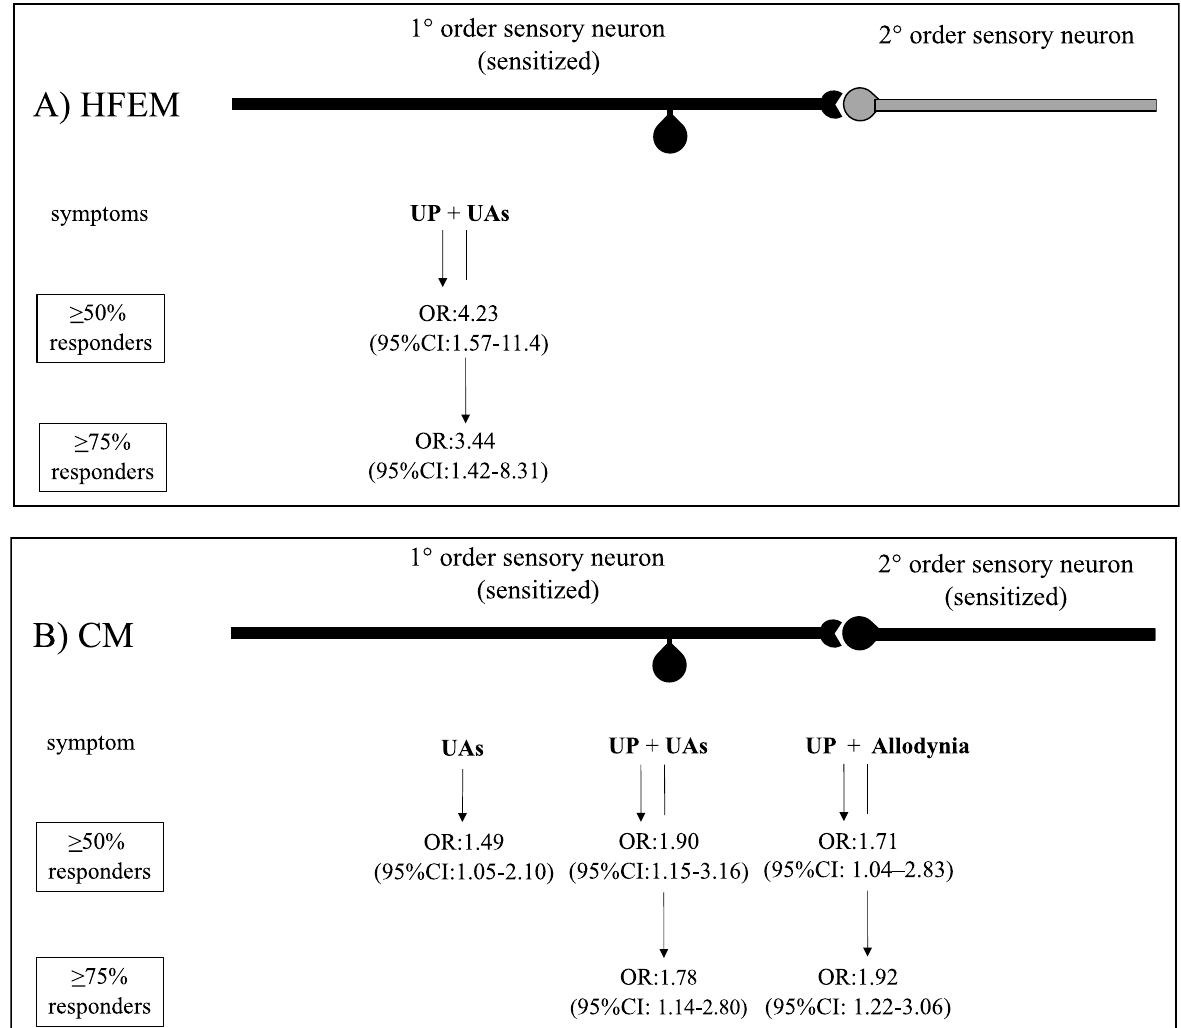
50 and 75% response to antiCGRP mAbs. B In patients with CM, UAs and UP ≥ ≥ UAs and UP associated with allodynia - a CGRP-mediated symptom of central sensitization +